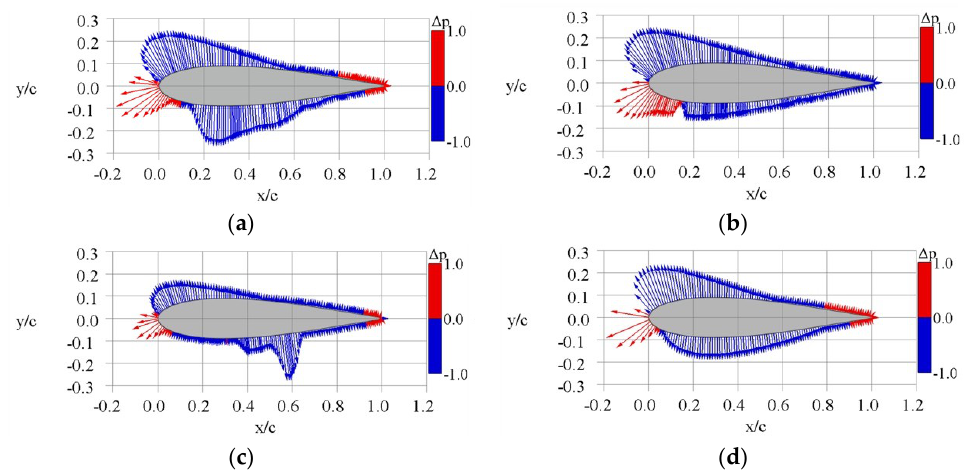
Figure 13. Surface pressure distributions on the blade cross-section of m = 25 in each rotor case with different cross-section arms: ( a ) airfoil arm rotor, ( b ) rectangular arm rotor, ( c ) circular arm rotor, and ( d ) armless rotor. The values of the color bars showing the surface pressure ∆ p have an arbitrary unit expressing just the direction of the surface pressure.